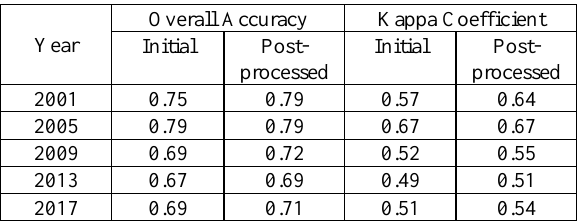
Table 1. Accuracy assessment of MODIS NDVI-derived land cover